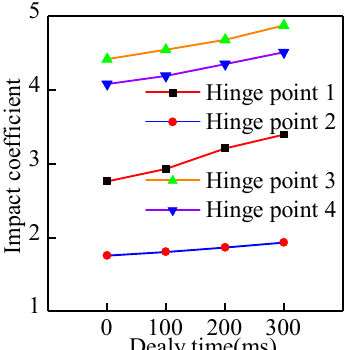
Figure 15. Impact coefficient of each hinge point at different delay